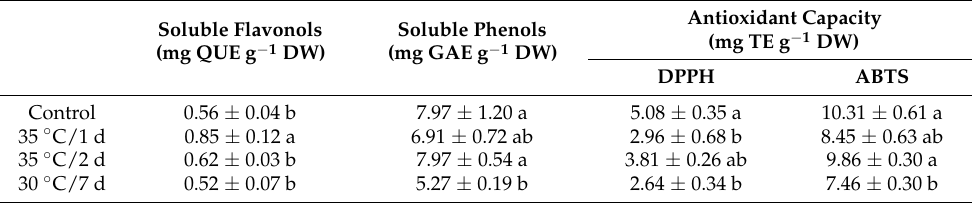
Table 1. Effect of high temperature on the content of flavonols and phenols and antioxidant capacity in H. sosnowskyi . Data are means ± SE ( n = 4). Values within the columns followed by the same letter(s) are not significantly different according to Tukey’s test ( p < 0.05).